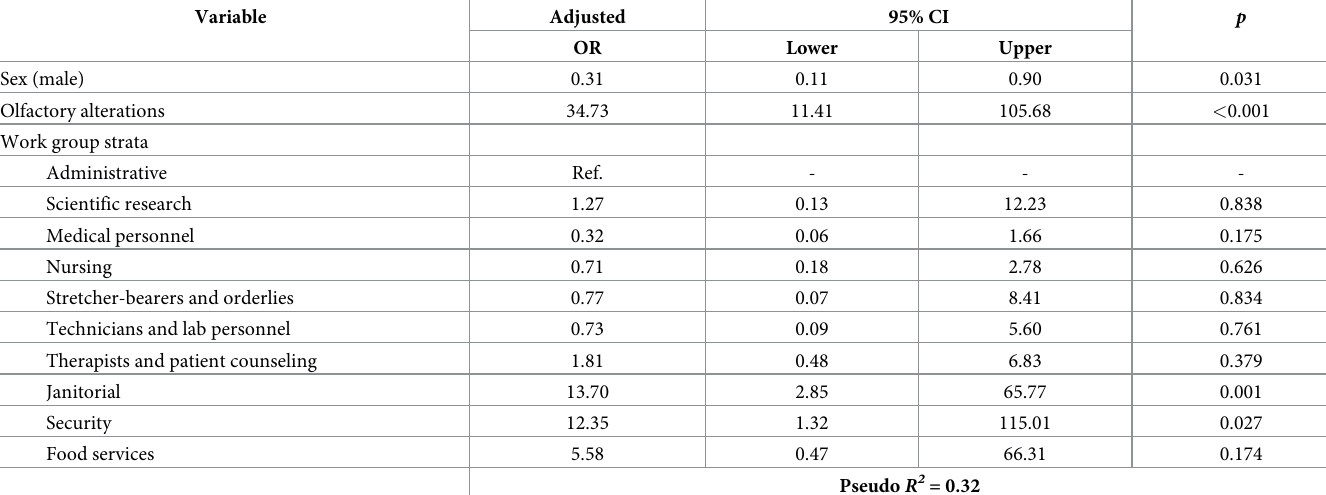
Table 3. Logistic regression model between associated variables and ELISA test